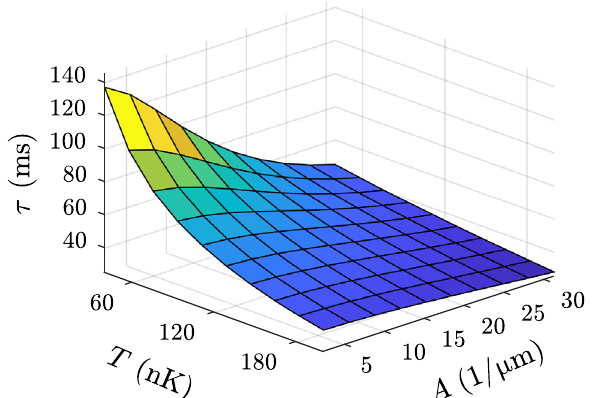
FIG. 11. Relaxation timescale τ obtained by fitting the first density mode δ n 1 ð t Þ from 1D GHD simulations with the damped oscillation of Eq. (4). The fitted timescale is shown as a function of temperature T and initial mode amplitude A . By increasing either the temperature or the mode amplitude, the spread in rapidities of the density perturbation increases, thus resulting in a faster